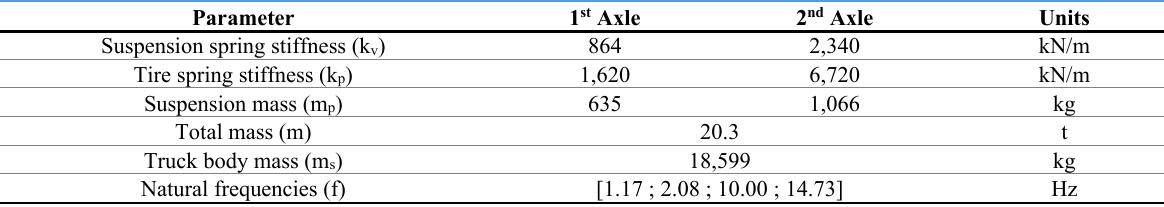
Table 1. Dynamic properties of the vehicle (2C vehicle: 2 axles).